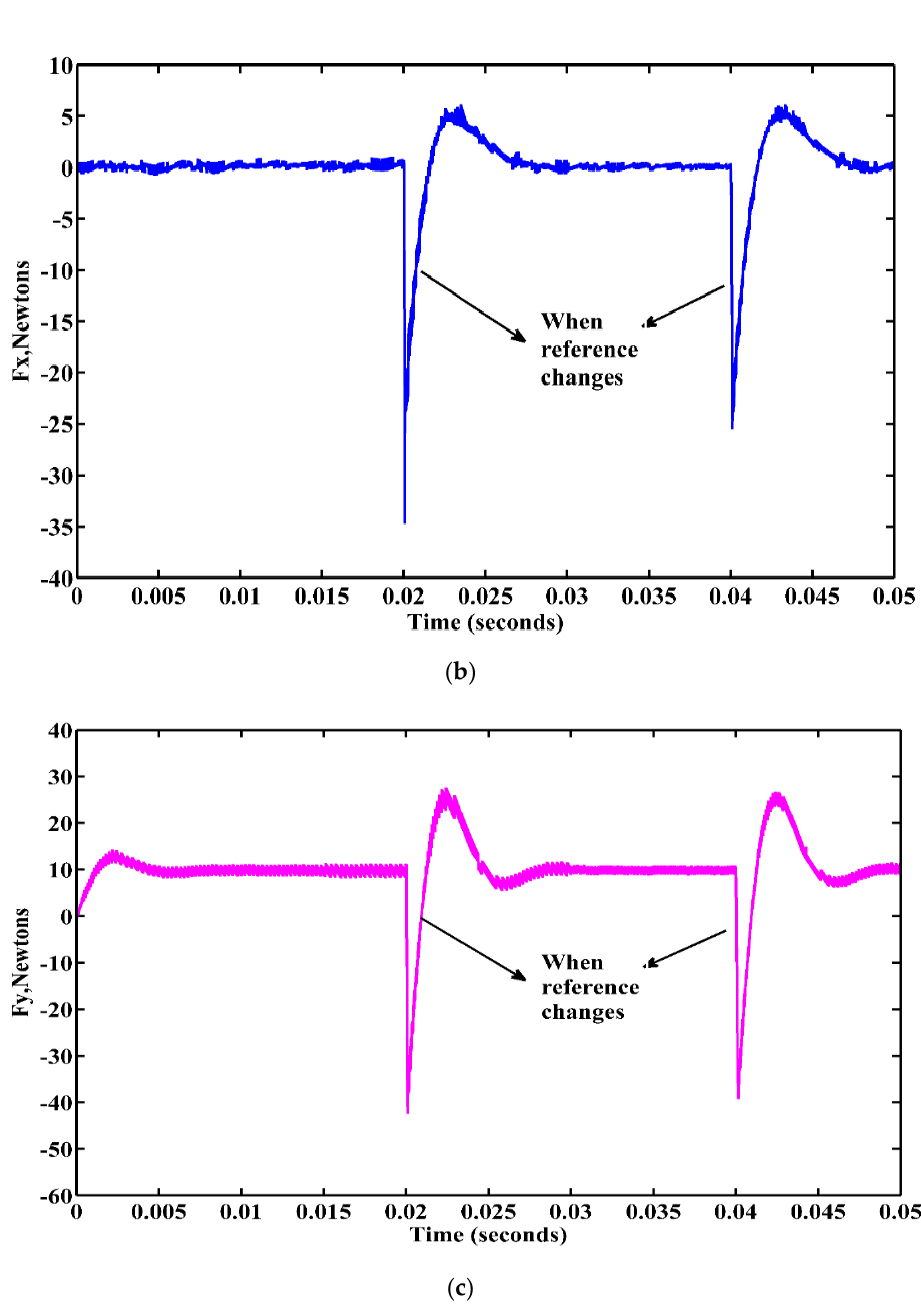
Figure 18. First Quadrant suspension Parameters. ( a ) Rotor Xand Y-axis dispalcements when references are changed; ( b ) Suspension force in the X direction. ( c ) Suspension force in the Y direction.